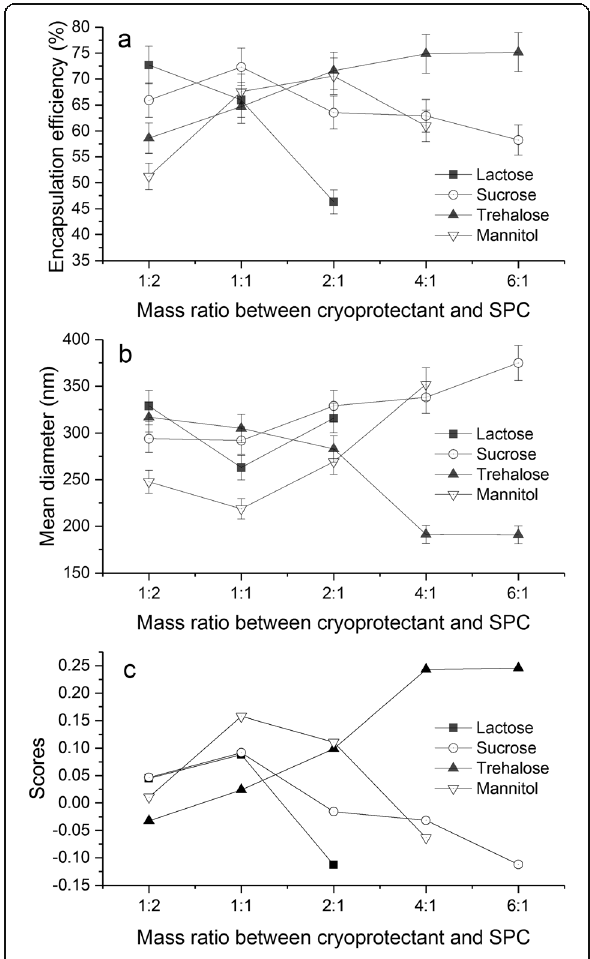
encapsulation efficiency ( a ), mean diameter ( b ) and scores ( c ) of reconstituted liposomes (mean ± SD, n =